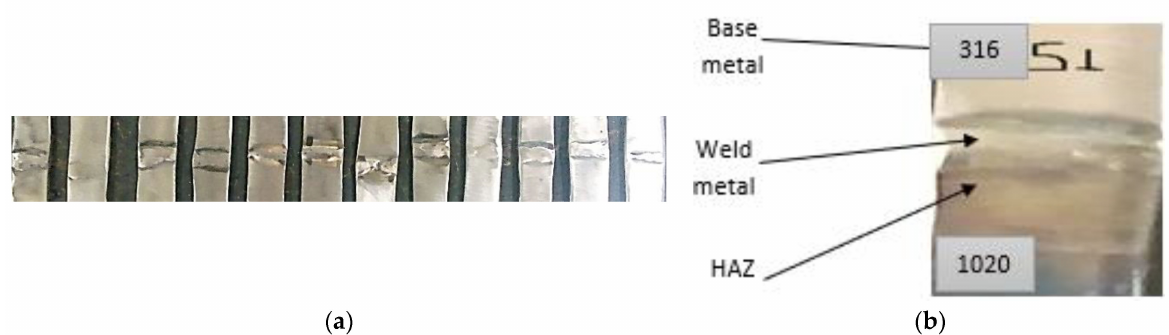
Figure 10. ( a ) Specimen prepared for hardness test; ( b ) three zones of